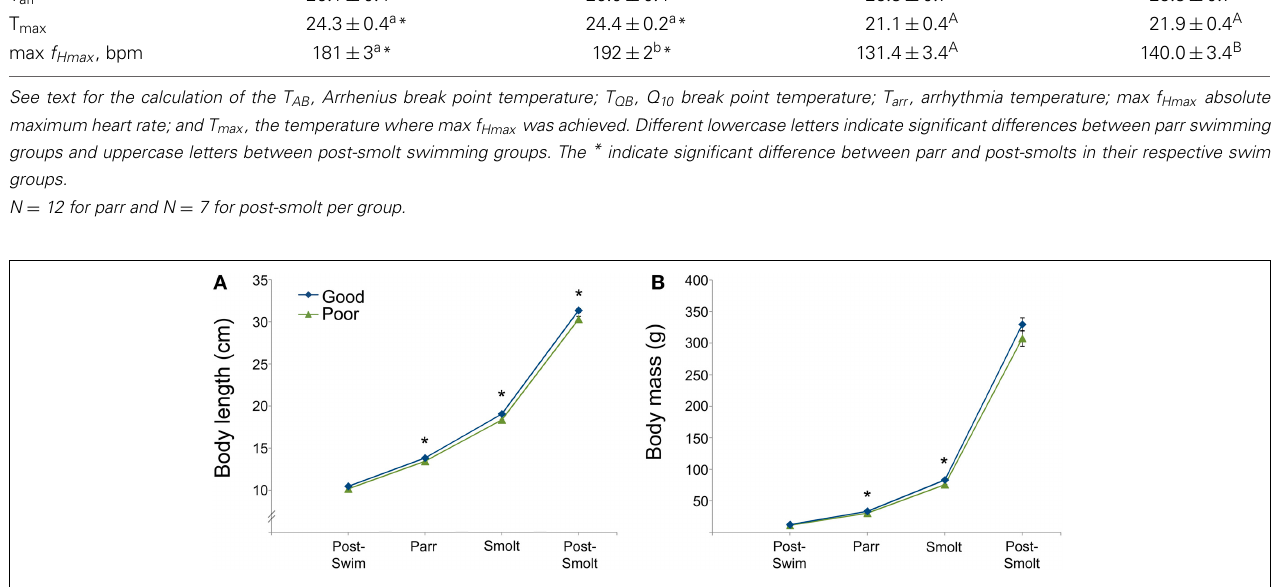
stage 4 weeks post-swimming (wps, N = 960 per group), at smolt stage 14 wps ( N = 960 per group), at post-smolt stage ( N = 28 per group). ∗ Indicates significant difference between swimming